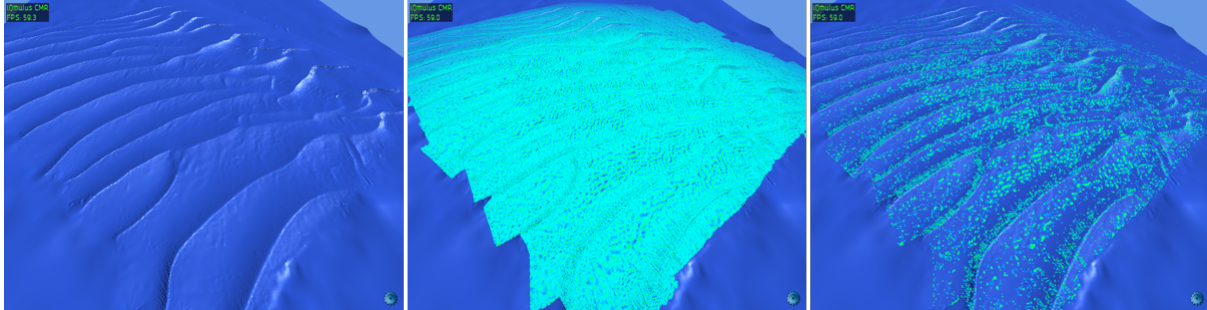
Figure 3: LR-Spline surface (left), combined with full input point cloud (middle) and showing only input points with high error compared to the reconstructed surface (right). The thresholding of points according to their distance to the surface is interactive, and enables a user to quickly inspect the quality of the spline surface.